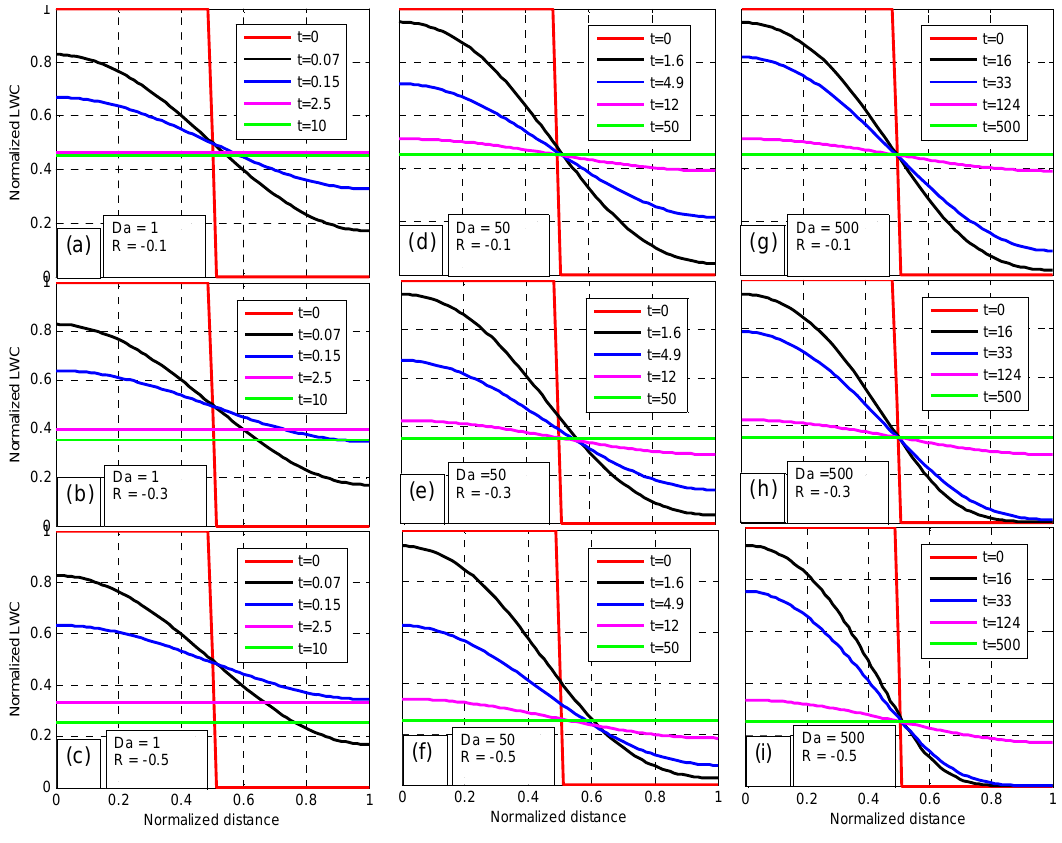
Figure 8. Profiles of normalized LWC at different Da and at different R > − 1.